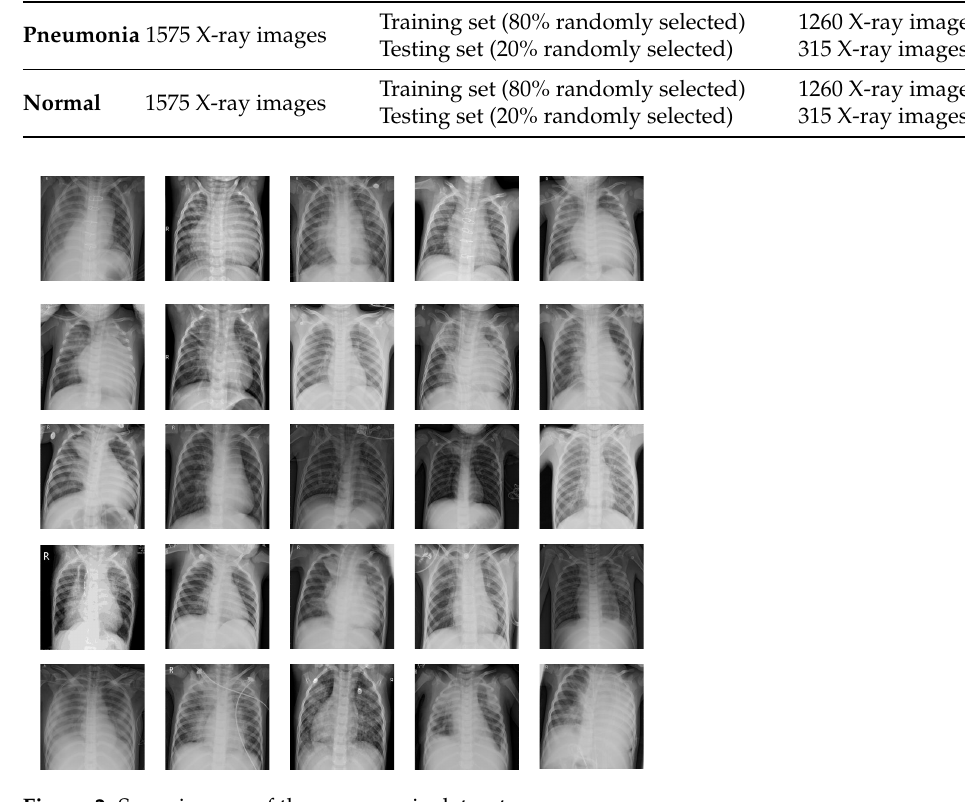
Figure 2. Some images of the pneumonia dataset.